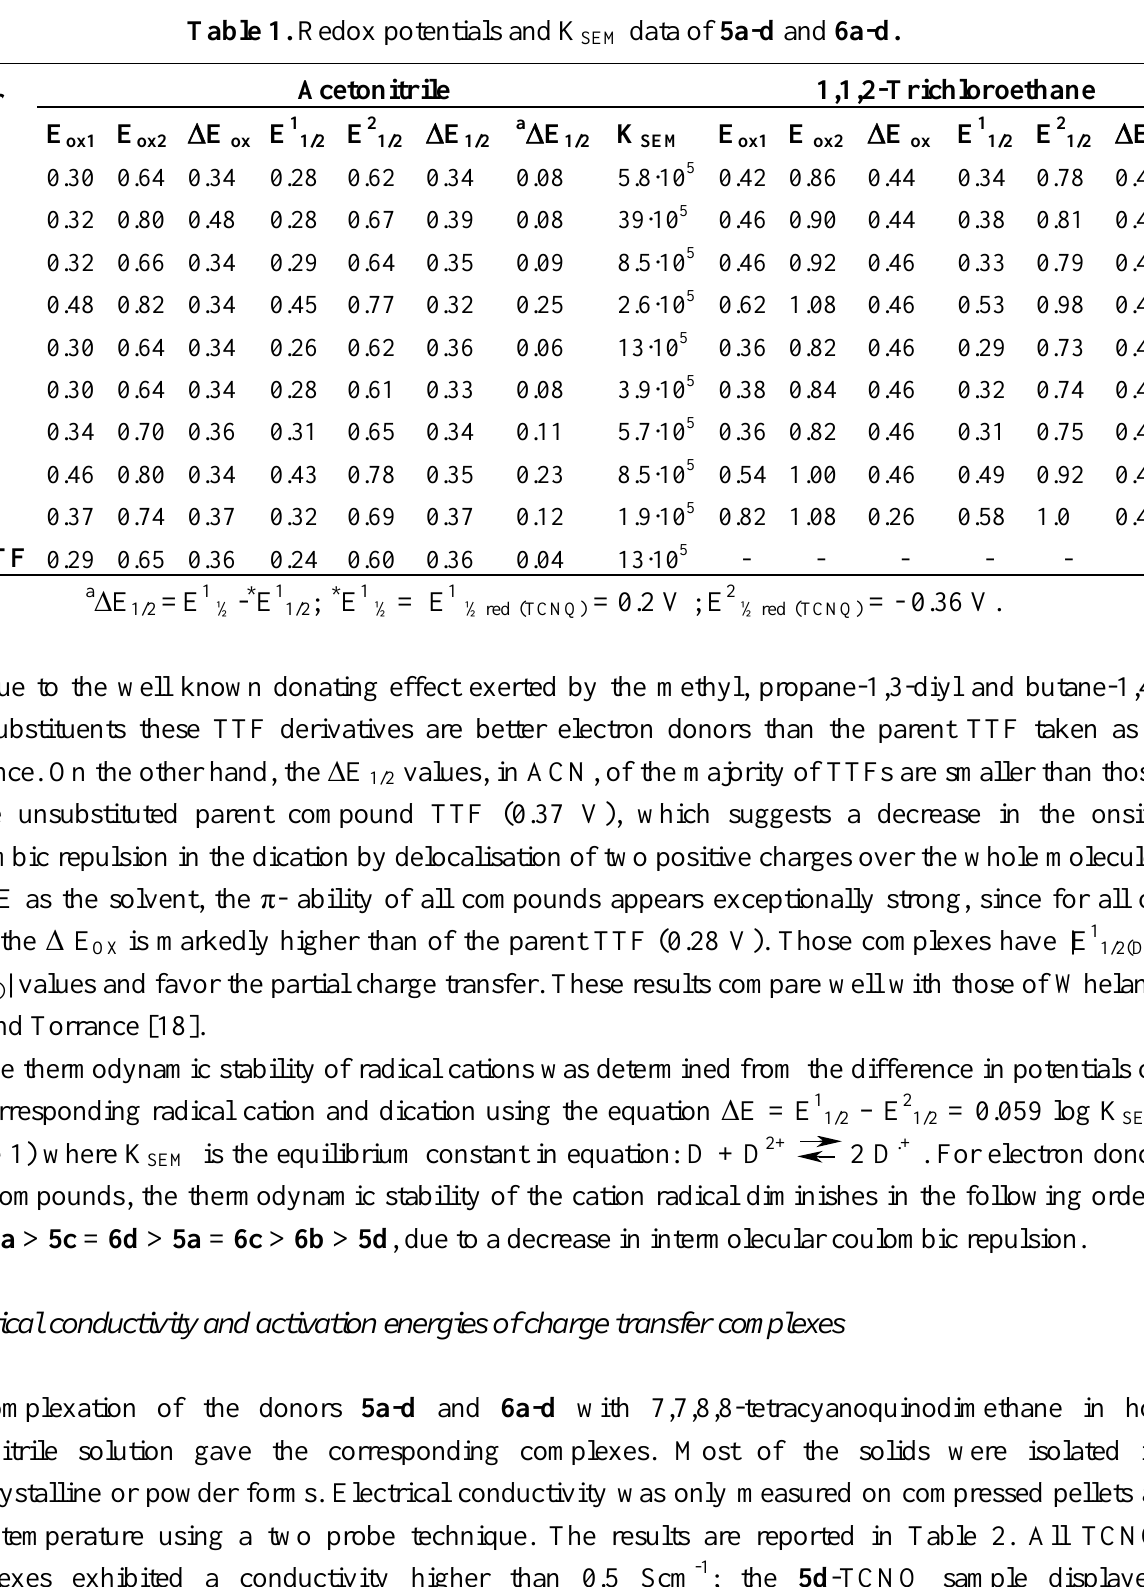
Table 1. Redox potentials and K